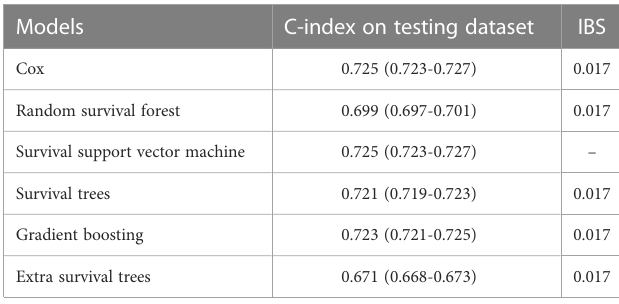
TABLE 2 C-index and integrated Brier score for the testing